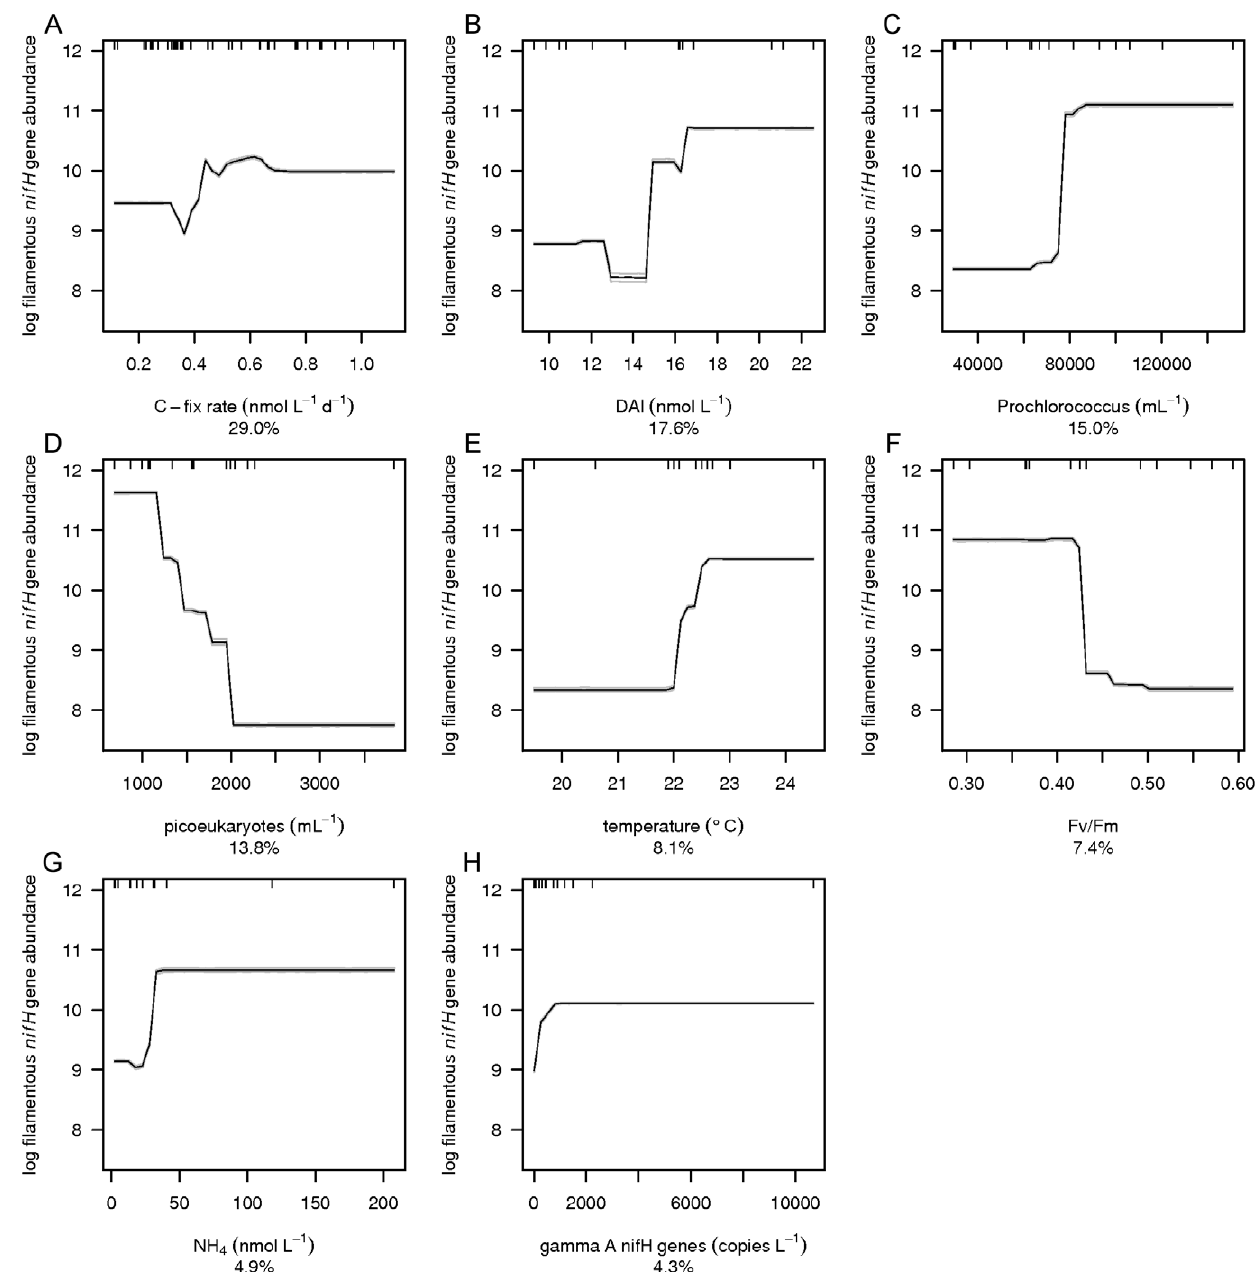
Figure 7. Mean partial dependence plots for the environmental variables describing the filamentous nifH gene abundance. Mean partial dependence plots with 95% confidence intervals (light grey, based on bootstrapping of 30 BRT runs and indicating robustness of model performance) for the 8 environmental variables which explain the variation in filamentous nifH gene abundance best. The 8 environmental variables are A) C-fix rate, B) DAl, C) Prochloroccocus , D) picoeukaryotes, E) F v /F m , F) NH 4 + , G) temperature and H) gamma A nifH genes. The y-axis is centered to have zero mean over the log distribution of the fitted filamentous nifH gene abundance. A common scale is used for the x-axis. Rug plots at inside top of plots show the distribution of sites across that variable, in deciles. physiological stress on the photosystem in the overall community F v /F m , the photochemical efficiency, and s PSII , the photosystem II and strengthen the competitiveness of N 2 -fixing organisms effective absorption cross section, both give information about effects of physiological stress on the photosystem and changes in resulting in the observed negative relationships between the community structure [60]. The magnitude in variability of F v /F m photophysiological variables and filamentous nifH gene abundance and N 2 fixation rates (Fig. 7 and 8). Alternatively, the change of and s PSII due to changes in phytoplankton community structure often exceeds that induced by nutrient limitation [60]. As filamentous nifH gene abundance and N 2 fixation with these discussed above, the most likely limiting nutrient in the vicinity photophysiological variables may represent a change in commu- of the Cape Verdes was nitrogen. Nitrogen limitation may cause nity structure. Chl a concentrations, contributing 6% to predicting